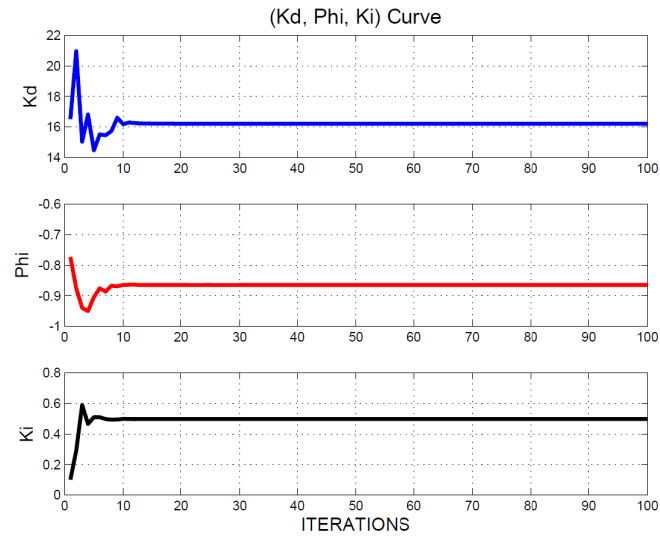
Sensors 2015 , 15 , page–page